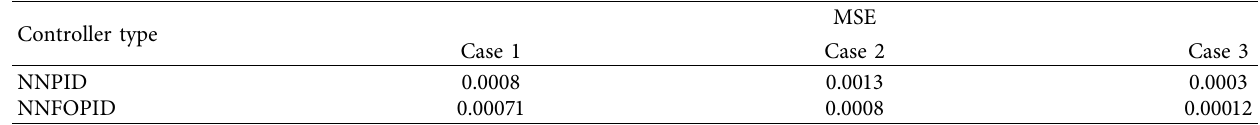
Table 4: The MSE for NNPID and NNFOPID controllers with EFFO.